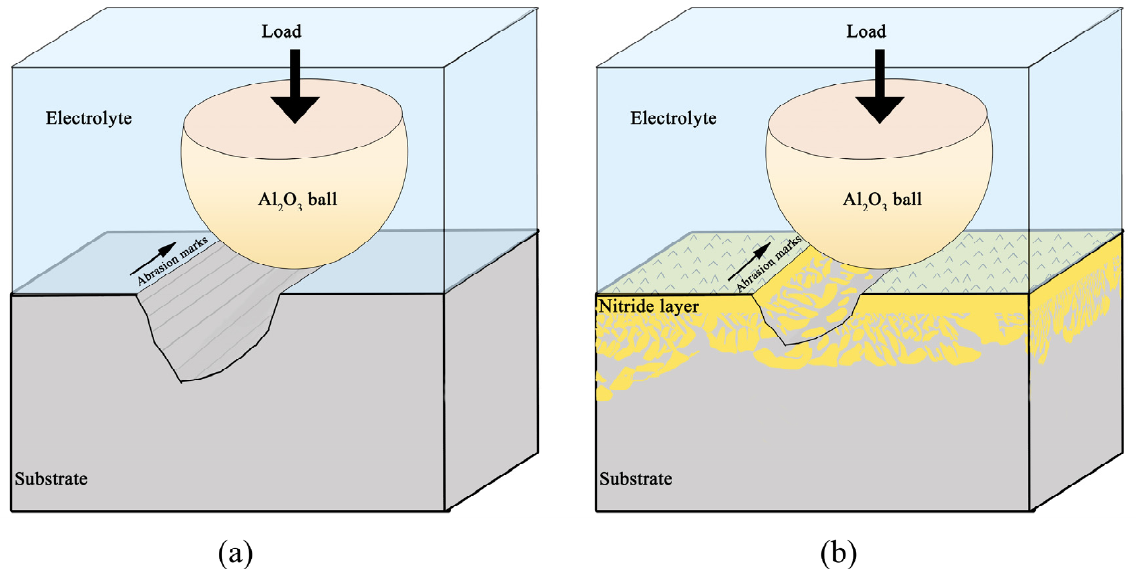
Figure 12. Schematic illustrations of tribocorrosion mechanisms for ( a ) Raw sample ( b ) Nitrided sample.